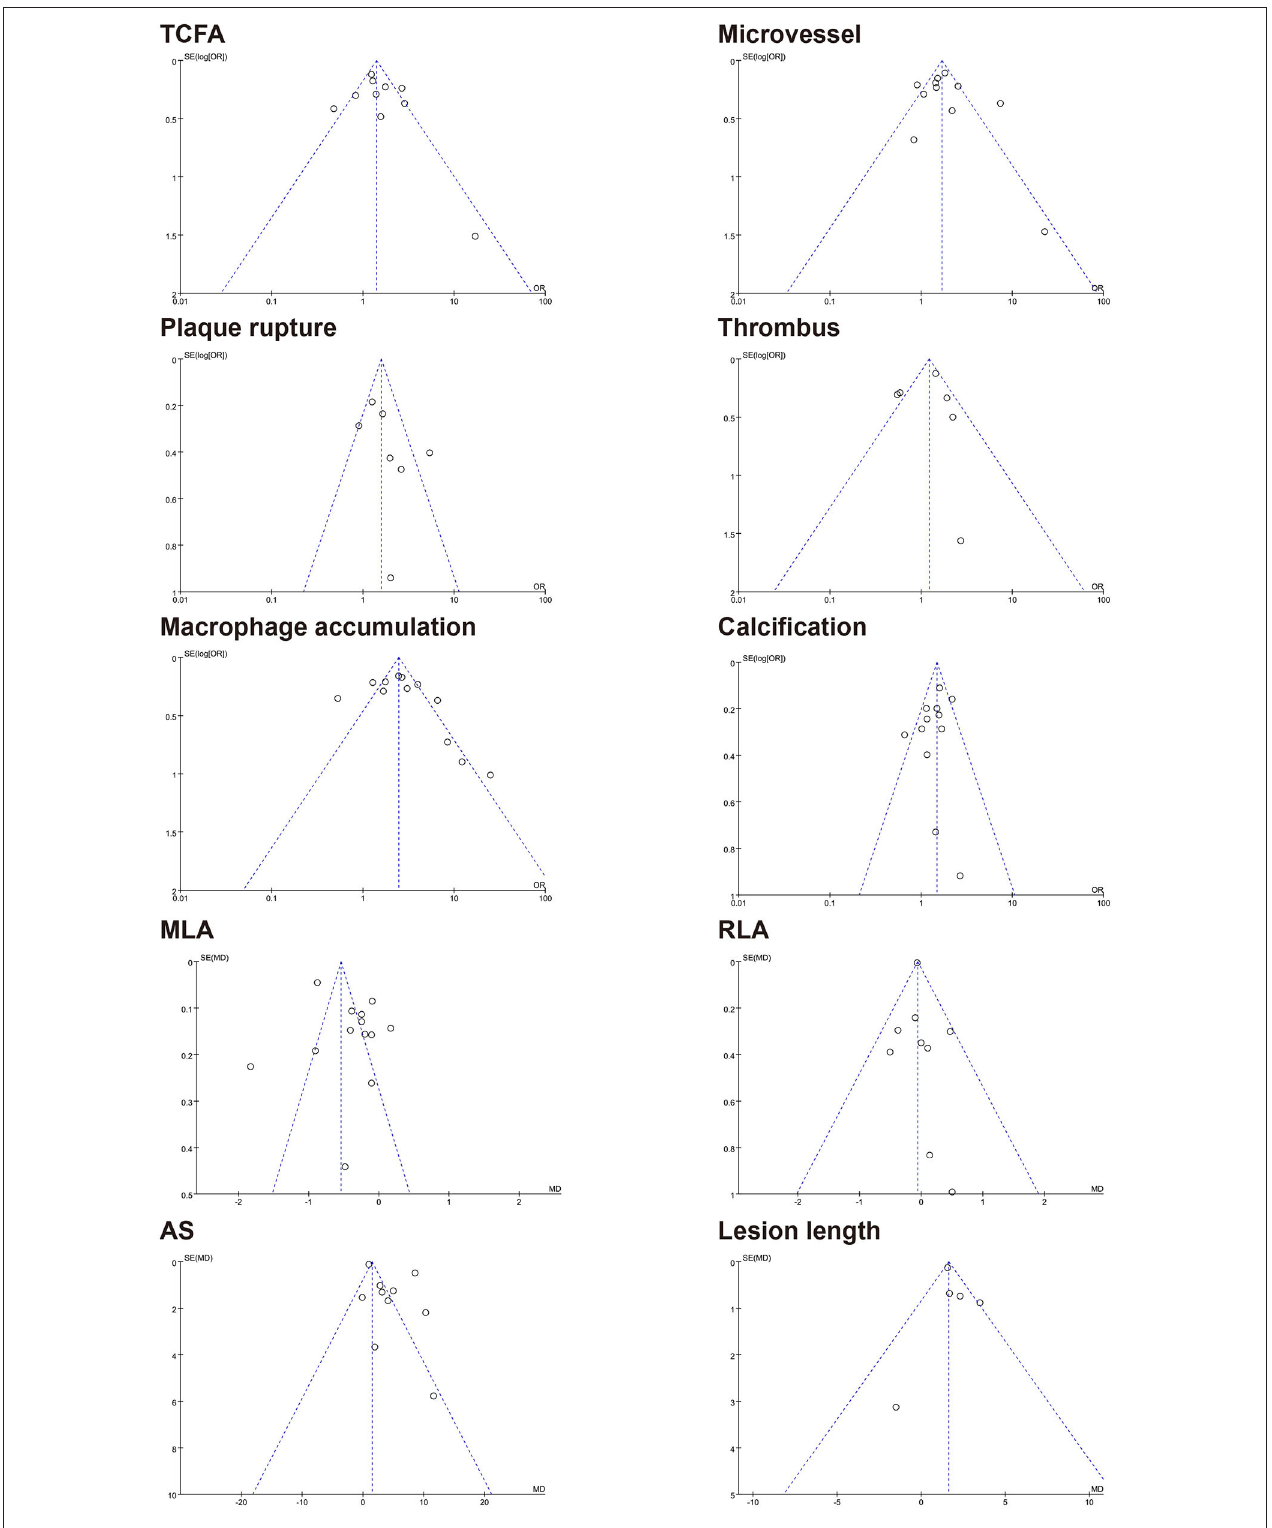
FIGURE 6 | Funnel plot for characteristics of healed plaque. TCFA, thin-cap fibroatheroma; MLA, minimal lumen area; RLA, reference lumen area; AS, area stenosis.